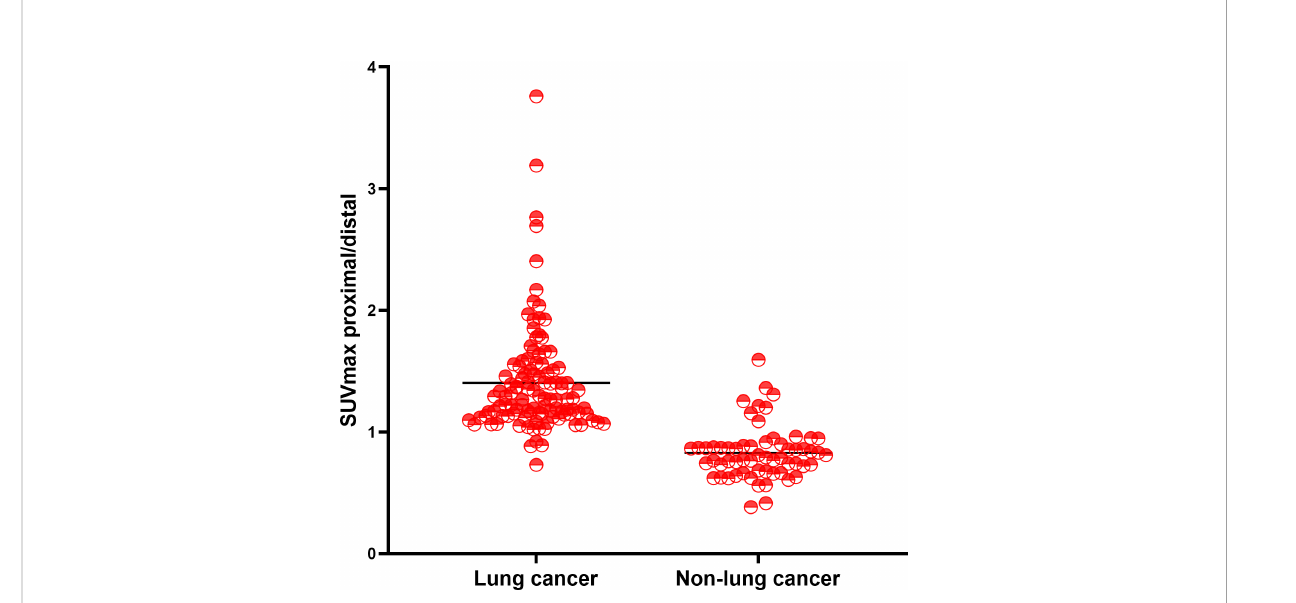
FIGURE 4 The ratio of SUVmax at the proximal end of the mass to SUVmax at the distal end of the